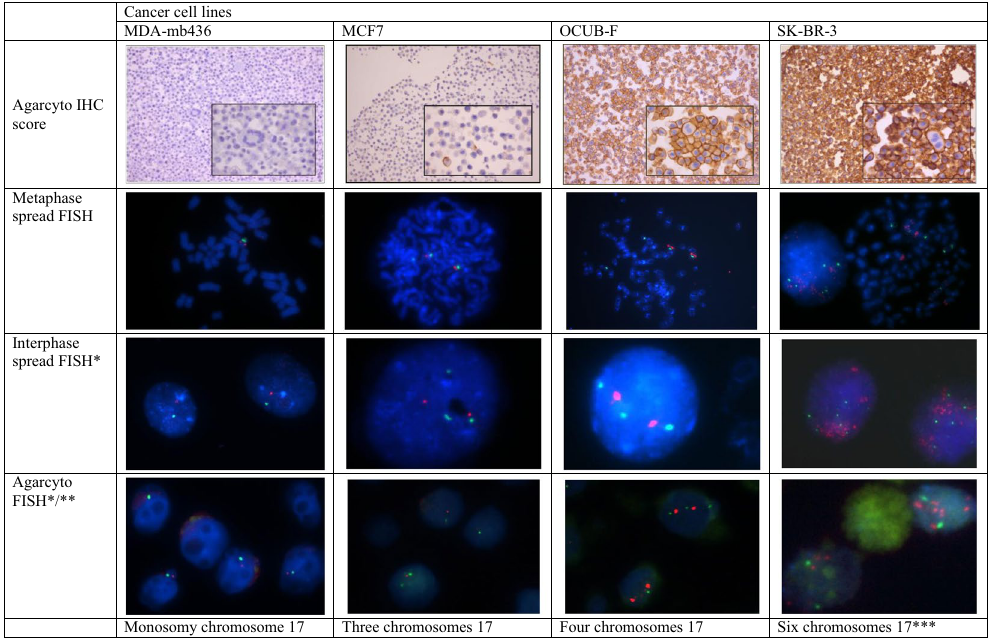
Figure 1. Examples of HER2 IHC of agarcyto slides and HER2 / CEP17 FISH results on metaphase spreads, interphase nuclei, and agarcyto slides. Due to focusing ( * ) or cutting artefacts ( ** ), not all of the spots of CEP17 (green) or the HER2 gene (red) may be visible. *** HER2 gene